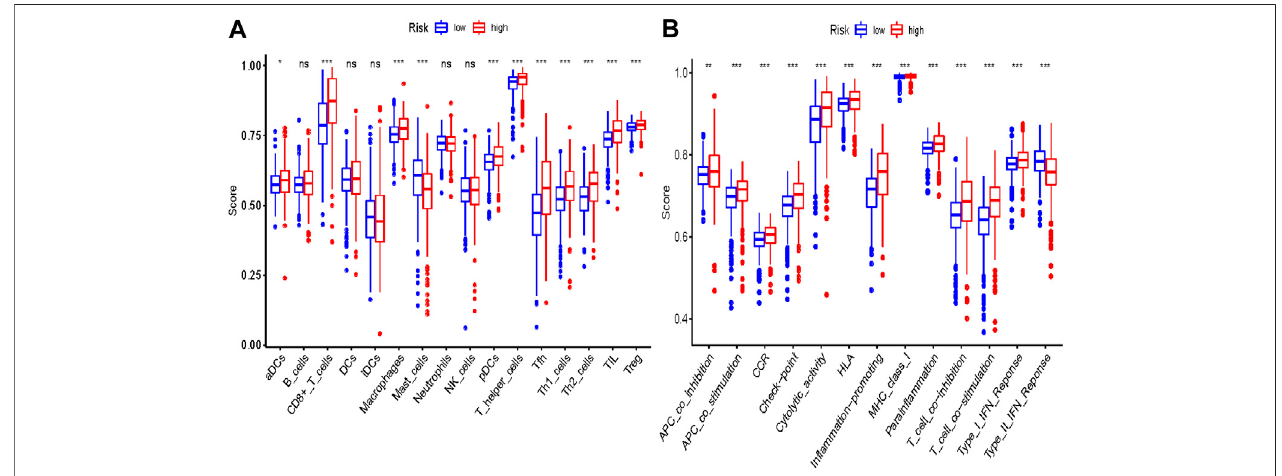
FIGURE 11 | Comparison of the ssGSEA scores between different risk groups in the TCGA cohort. The scores of 16 immune cells (A) and 13 immune-related functions (B) are displayed in boxplots. Adjusted p values were showed as: ns, not signi fi cant; *, p < 0.05; **, p < 0.01; ***, p <